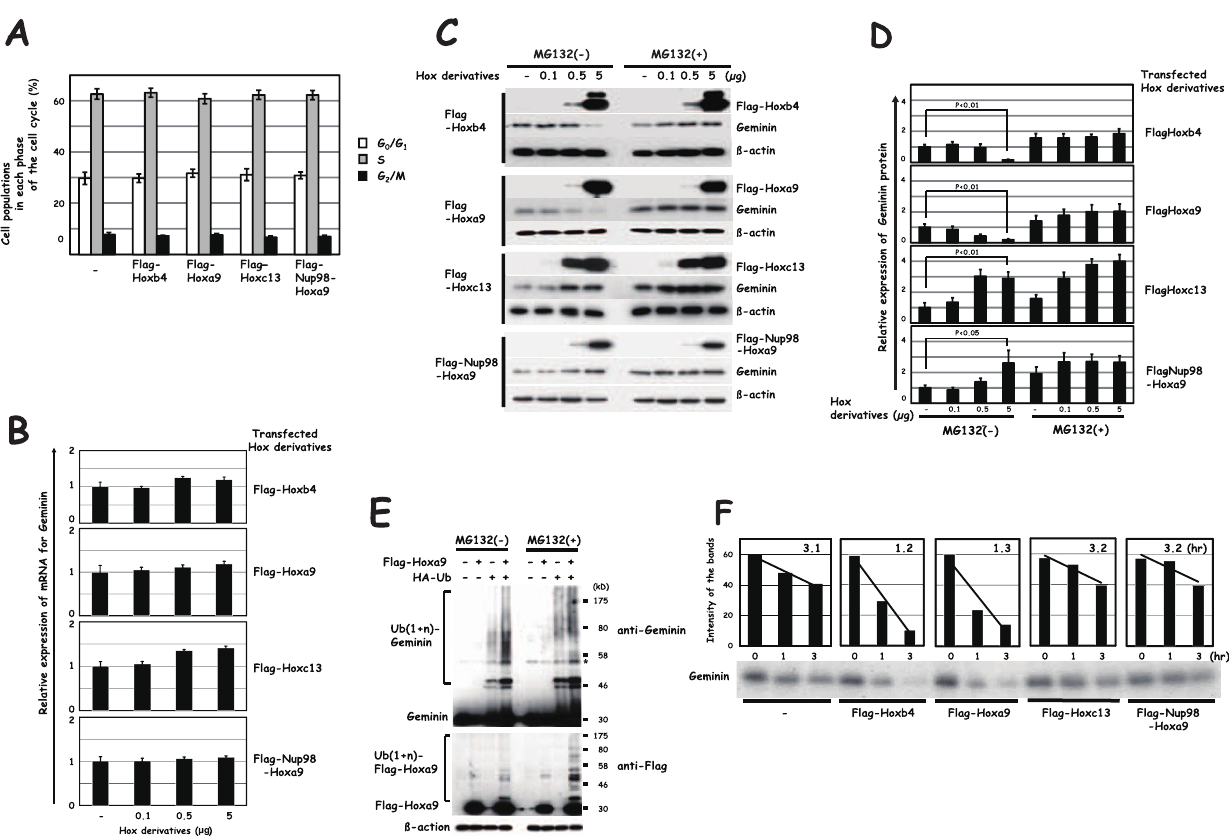
Figure 2. Effects of Hoxa9, Hoxc13 and Nup98-Hoxa9 transfection in HEK-293 cells. Either Flag-Hoxb4, Flag-Hoxa9, Flag-Hoxc13 or Flag- Nup98-Hoxa9 was transfected. Effect of Flag-Hoxb4 transfection was used as positive control. ( A ) Effect on the cell cycle. The percentages of cell subpopulations in each phase of the cell cycle are shown. ( B ) Effect on expression of mRNA for Geminin. mRNA for Geminin was detected by real- time PCR analysis. The amount of transfected Hox derivatives are shown in the x-axis. ( C ) Protein expression of transfected Hox derivatives and the effect on Geminin protein expression examined by immunoblot analysis. Flag-Hoxa9- or Flag-Hoxb4-induced down-regulation of Geminin was suppressed by treatment with MG132. ( D ) Quantitative analysis of Geminin protein expression in HEK-293 cells transfected with either Flag-Hoxb4, Flag-Hoxa9, Flag-Hoxc13 or Flag-Nup98-Hoxa9. Bands detected by immunoblot analysis of the three independent experiments were scanned with the Image J program (NIH). Relative expression of Geminin protein to that of ß-actin was subjected to statistical analysis. Representative findings of the immunoblot analysis were shown in Fig. 2C. ( E ) Ubiquitination of Geminin and Flag-Hoxa9. Geminin, and either Flag-Hoxa9 or HA-Ub, or both, were co-transfected. The cells were then treated with or without MG132, and were subjected to immunoblot analysis with anti-Geminin (upper panel) and anti-Flag antibodies (lower panel). ( F ) Effects of Flag-Hoxb4, Flag-Hoxa9, Flag-Hoxc13 and Flag-Nup98-Hoxa9 transfection on the stability of Geminin. [ 35 S]-labeled Geminin was traced by means of autoradiography after immunoprecipitation (lower panel). The detected bands were scanned with the Image J program (NIH), and the half-life of Geminin protein was calculated (insets in the upper panel). -, an empty control vector.